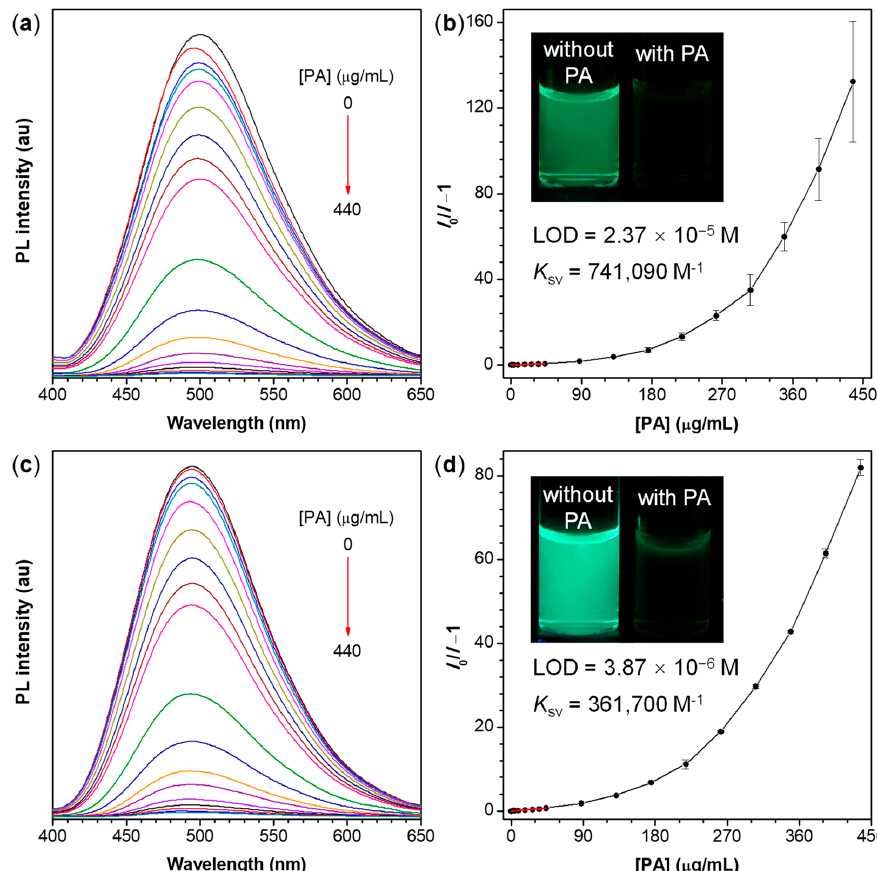
Figure 6. ( a , c ) PL spectra of ( a ) P 1 / 2 -I and ( c ) P 1 / 2 -II in THF/water mixtures with 80% water fraction containing different amounts of picric acid (PA); ( b , d ) Stern-Volmer plots of ( I 0 / I − 1) of ( b ) P 1 / 2 -I and ( d ) P 1 / 2 -II versus the PA concentration, where I = peak intensity and I 0 = peak intensity without PA. Solution concentration: 10 μ M; excitation wavelength: 350 nm. Inset in panel ( b , d ): fluorescent photographs of P 1 / 2 -I and P 1 / 2 -II in THF/water mixture with f w of 80% without and with PA taken under 365 nm UV illumination from a hand-held UV lamp.